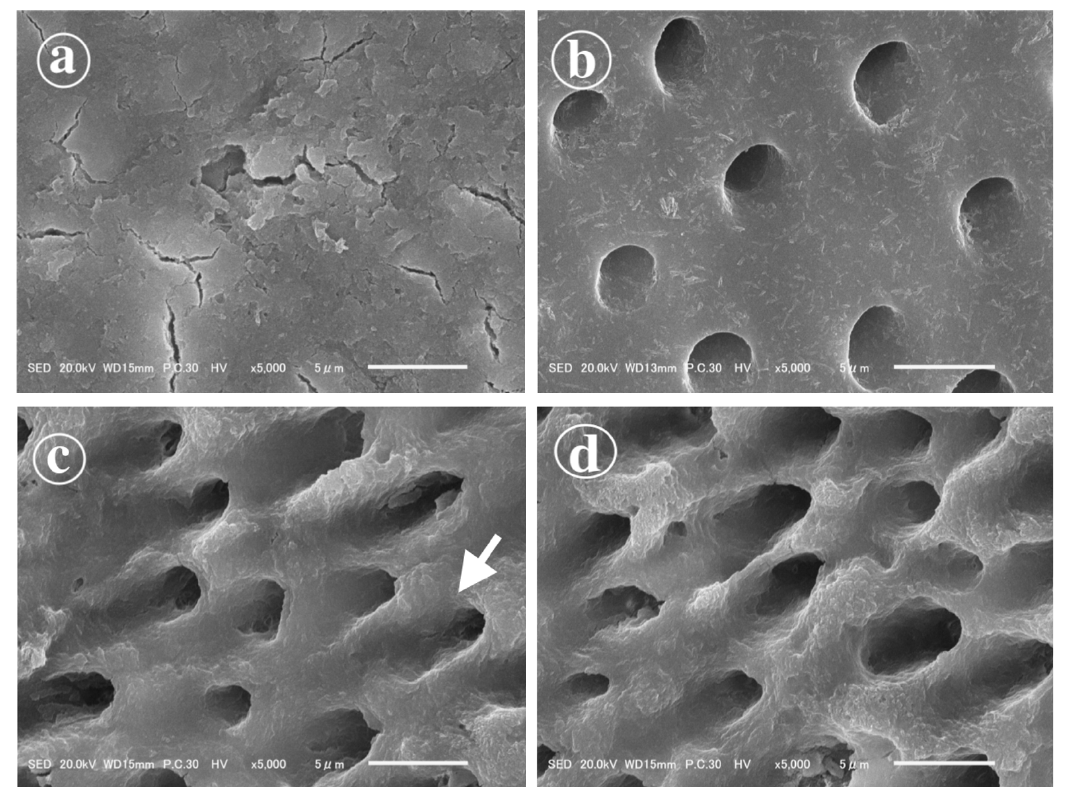
Figure 2. Scanning electron micrographs of the dentin surfaces. ( a ) The dentin surface in the control group was covered by a smear layer. ( b ) Smear layer was not present on eroded dentin, and collagen fibrils were observed on the untreated surface. ( c ) After deproteinization of eroded dentin with 10% NaOCl, the orifices of dentinal tubules were enlarged to a funnel shape (indicated by the white arrow), and the surface was very porous. ( d ) The application of the STS-containing agent did not alter the surface morphology.